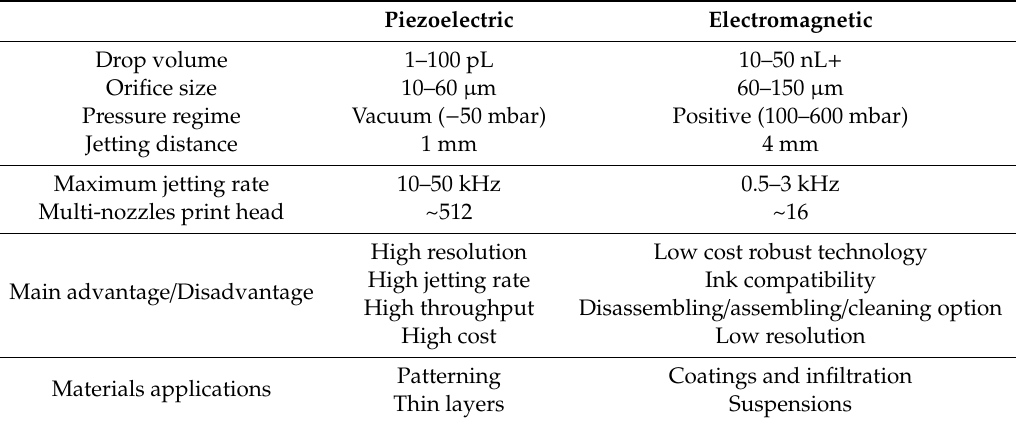
Table 2. Basic characteristics of inkjet printing technologies.